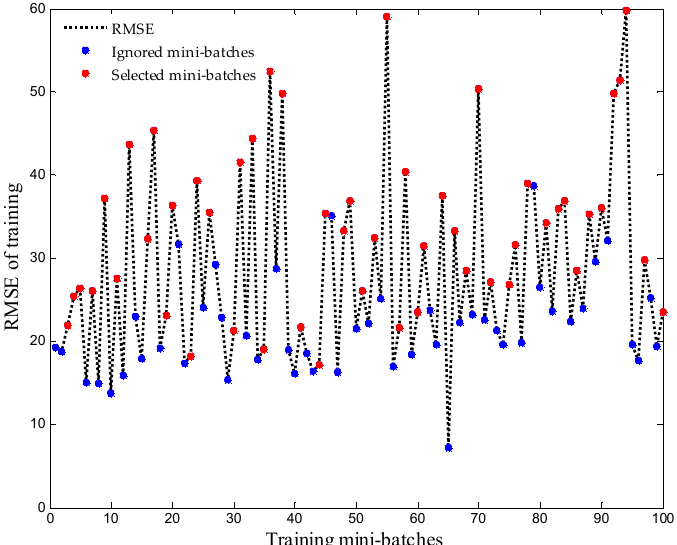
Figure 5. The behavior of USS (Updated Selection Strategy) strategy towards the unused training mini batches.